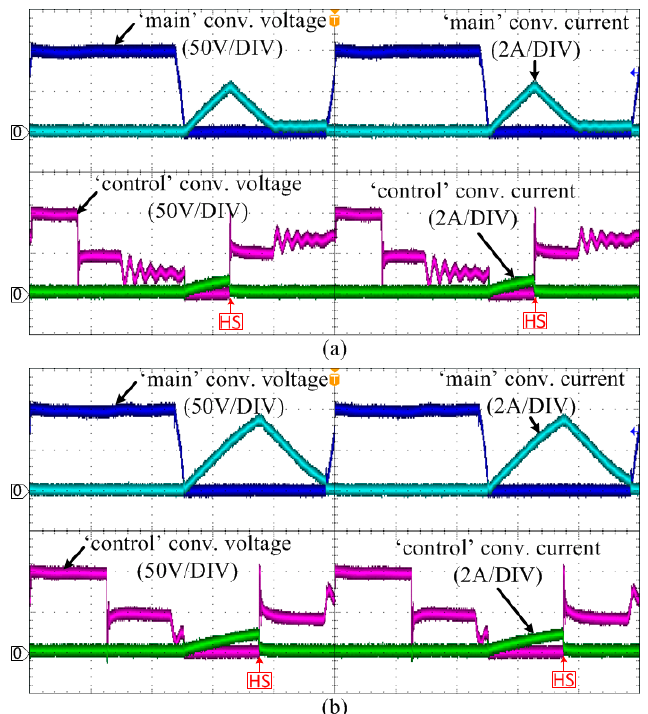
Figure 15. Voltage and current waveforms in the IGBT switch (input-side) when the BiDUP converter operates in the forward mode with the ‘control’ converter duty-ratios of ( a ) 0.15 and ( b ) 0.25, respectively.